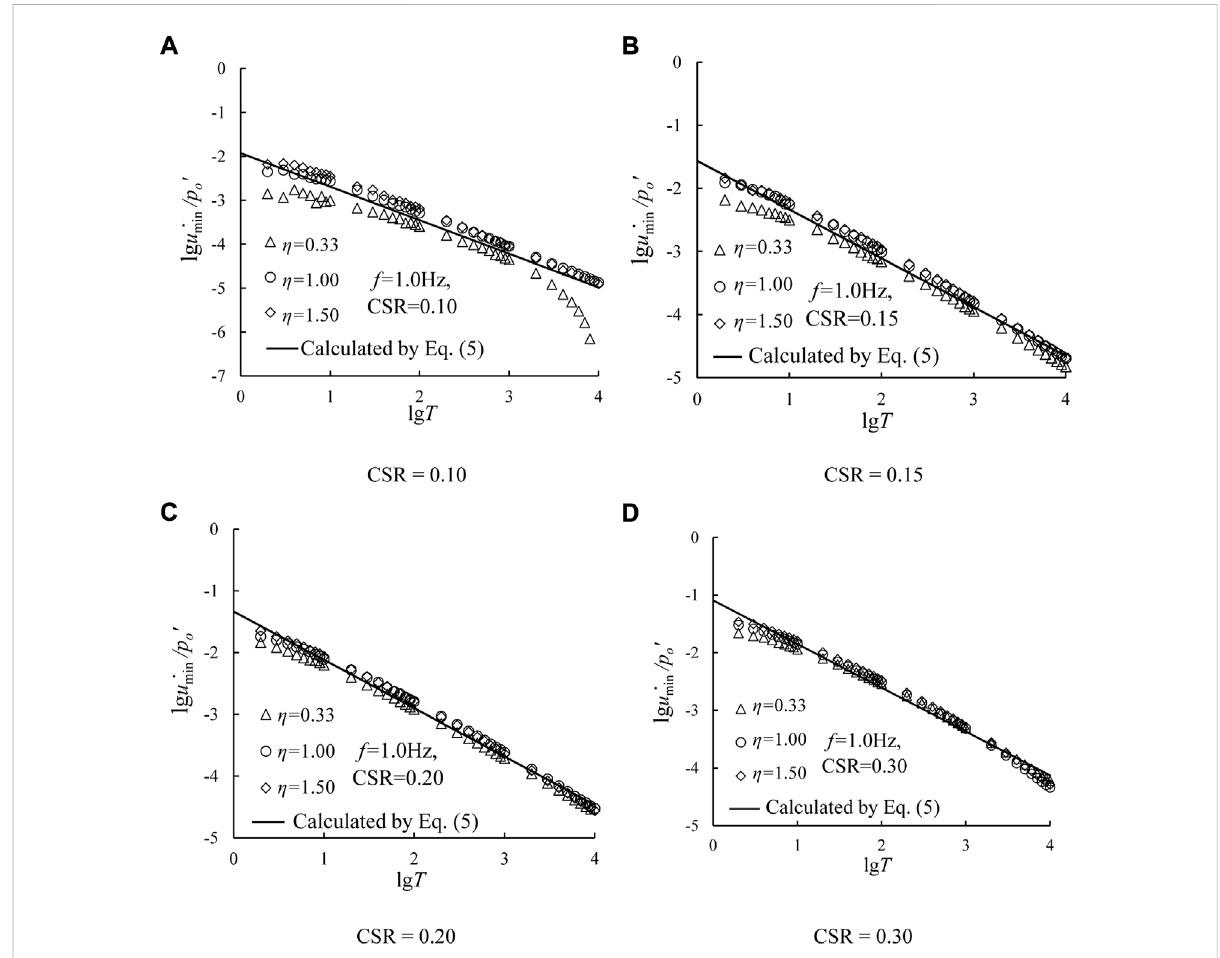
FIGURE 12 Relationshipsbetweenlg _ u min / p ′ o versuslg T underdifferent η valuesfor f =1.0 Hz. (A) CSR=0.10; (B) CSR=0.15; (C) CSR=0.20; (D) CSR=0.30.